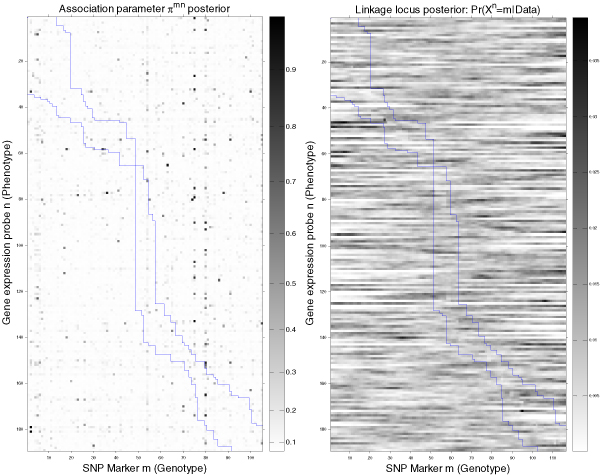
Gene expression × Genotype associations and residual linkage summary. Left, Image describing the mean value of the association parameters πnm between the gene expression phenotypes (rows) and the SNP genotypes (columns). The matrix shows that the interactions are very sparse (dark spots), meaning that phenotypes are controlled by small number of SNPs, with no apparent concentration along the cis region delimited by blue lines. However, there exist some SNPs (columns) that seem to be correlated with a large set of phenotypes, potentially indicating a master regulatory region. Right, Image describing the posterior probability of the linkage locus after removing the association effect from the covariance.